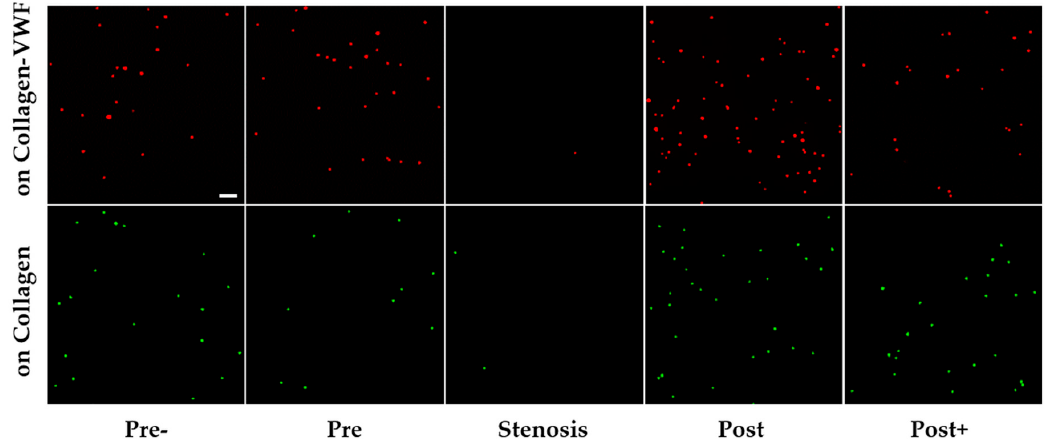
Figure 2. The spatial adhesion of A1-NPs in collagen-VWF vs. collagen-coated 75% stenotic models. ( a ) Computational fluid dynamics (CFD) results and spatial zones along the model. (1) Wall shear stress CFD results for the 75% stenosis model (note: color bar is in log-scale). (2) Streamlines CFD results. (3) A scheme showing the spatial deposition zones along the stenosis model: 1-Pre-, 2- Pre, 3- Stenosis, 4- Post, 5- Post+. ( b ) The normalized A1-NPs deposition at the different zones as a function of model’s coating: Collagen vs. collagen-VWF. ( c ) Representative fluorescent microscopy image of A1-NPs spatial deposition in stenosis model. Left: in a collagen-VWF-coated model (red). Right: in a collagen-coated model (green). Scale: 1 cm.